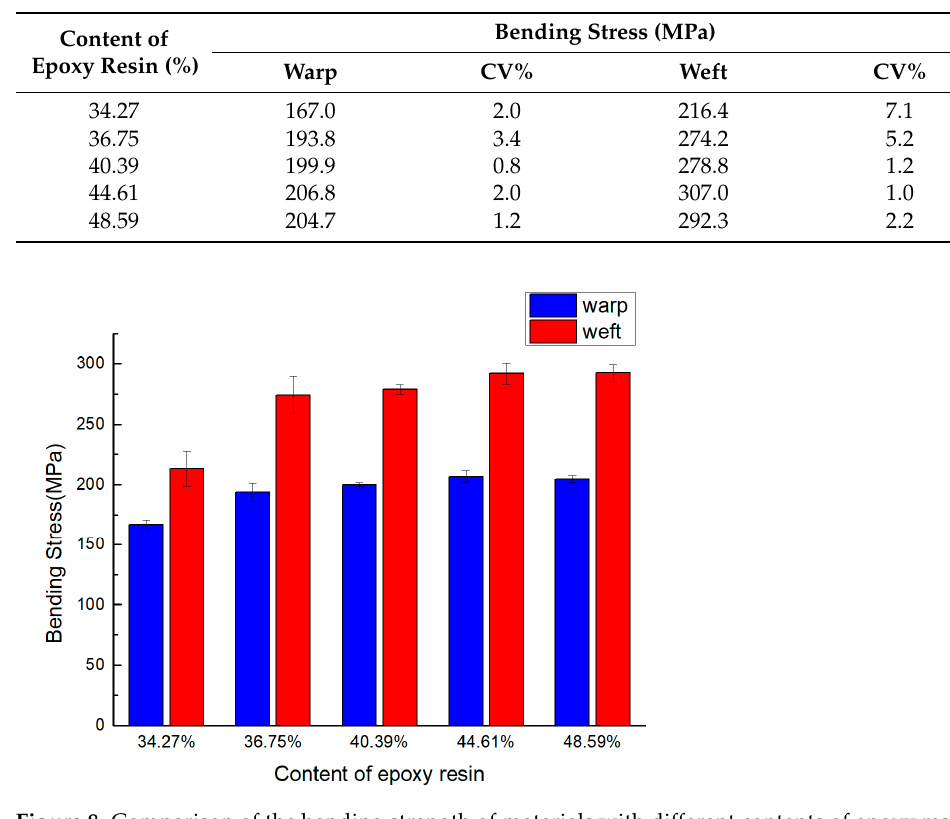
Figure 8. Comparison of the bending strength of materials with different contents of epoxy resin.